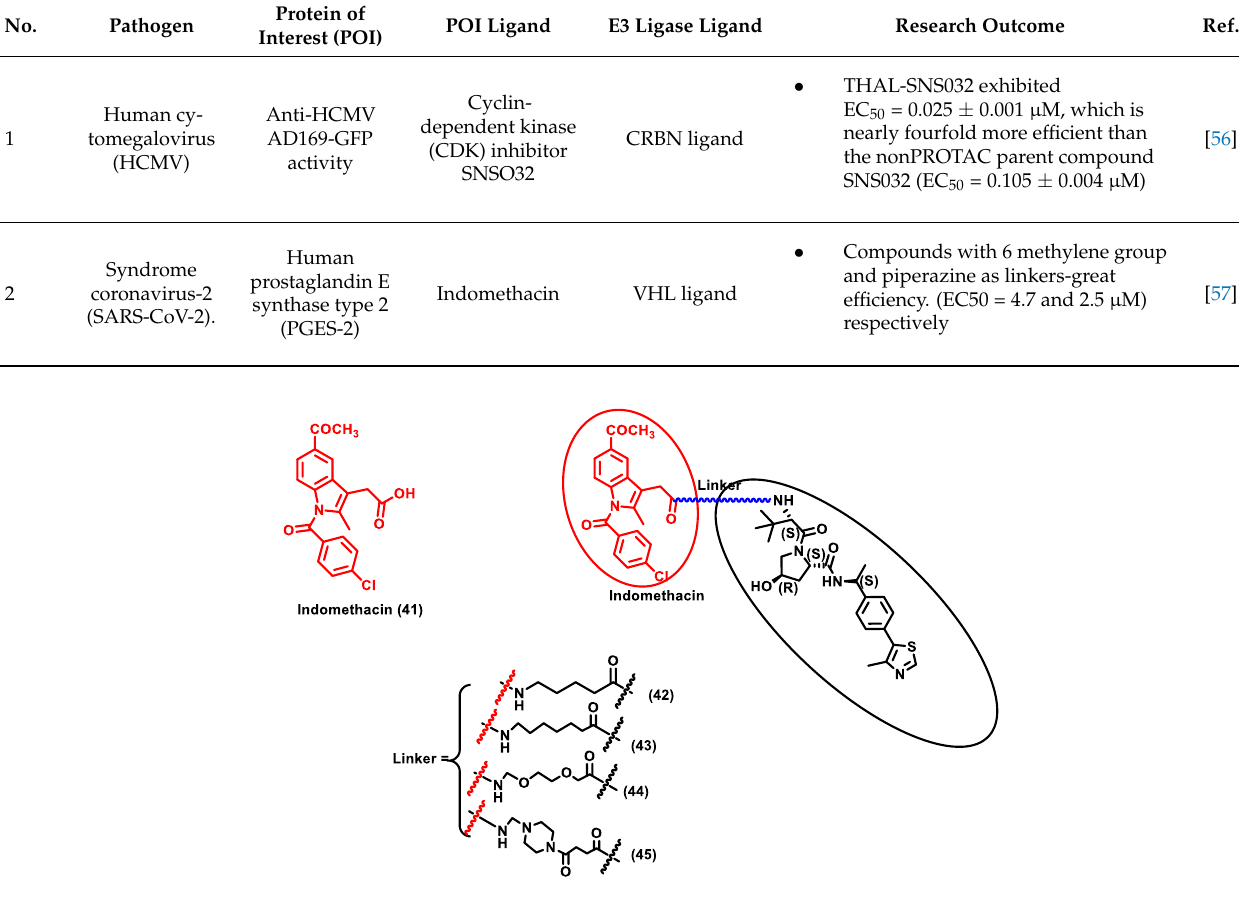
Figure 6. Structures of the PROTAC molecules are used for the degradation of host proteins. The red circle indicates the POI ligand; the blue wavy line indicates the linker; the black circle indicates the E3 ligand moiety.